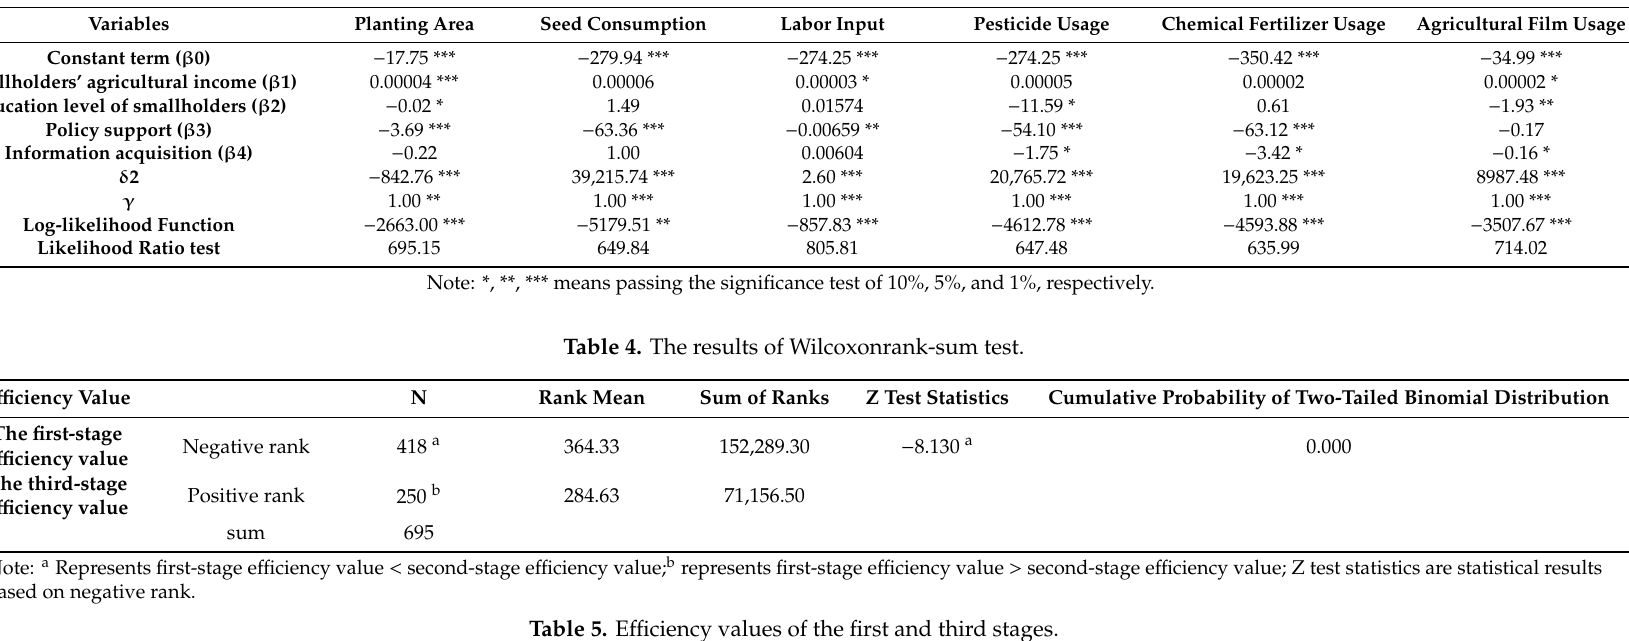
Table 3. Results of the stochastic frontier analysis (SFA) regression.